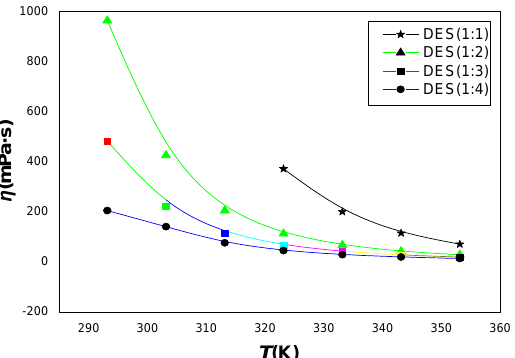
Figure 3. The change in experimental viscosity values of prepared DESs with temperature.